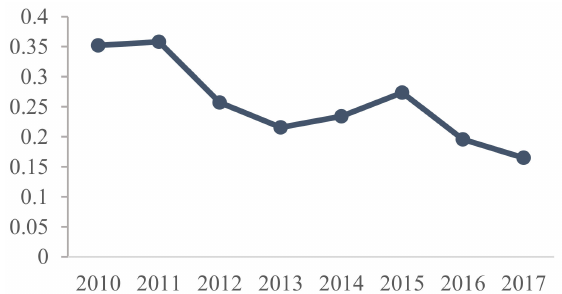
Figure 6. Global Moran’s I of coupling coordination degree from 2010 to